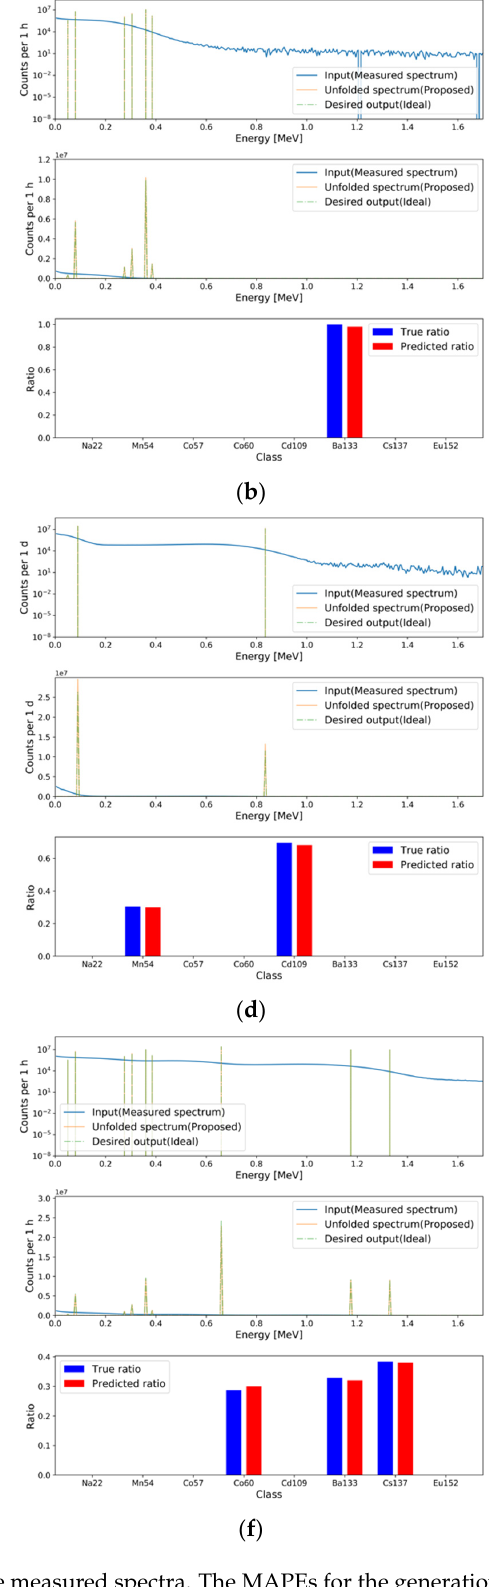
Figure 7. Examples of the generation and regression results for the measured spectra. The MAPEs for the generation and regression tasks, respectively, were ( a ) 1.539 × 10 − 2 and 5.001 × 10 − 1 ; ( b ) 3.616 × 10 − 2 and 2.499 × 10 − 1 ; ( c ) 1.483 × 10 − 1 and 5.001 × 10 − 1 ; ( d ) 5.531 × 10 − 2 and 4.637 × 10 − 1 ; ( e ) 5.752 × 10 − 2 and 5.508 × 10 − 1 ; ( f ) 6.046 × 10 − 2 and